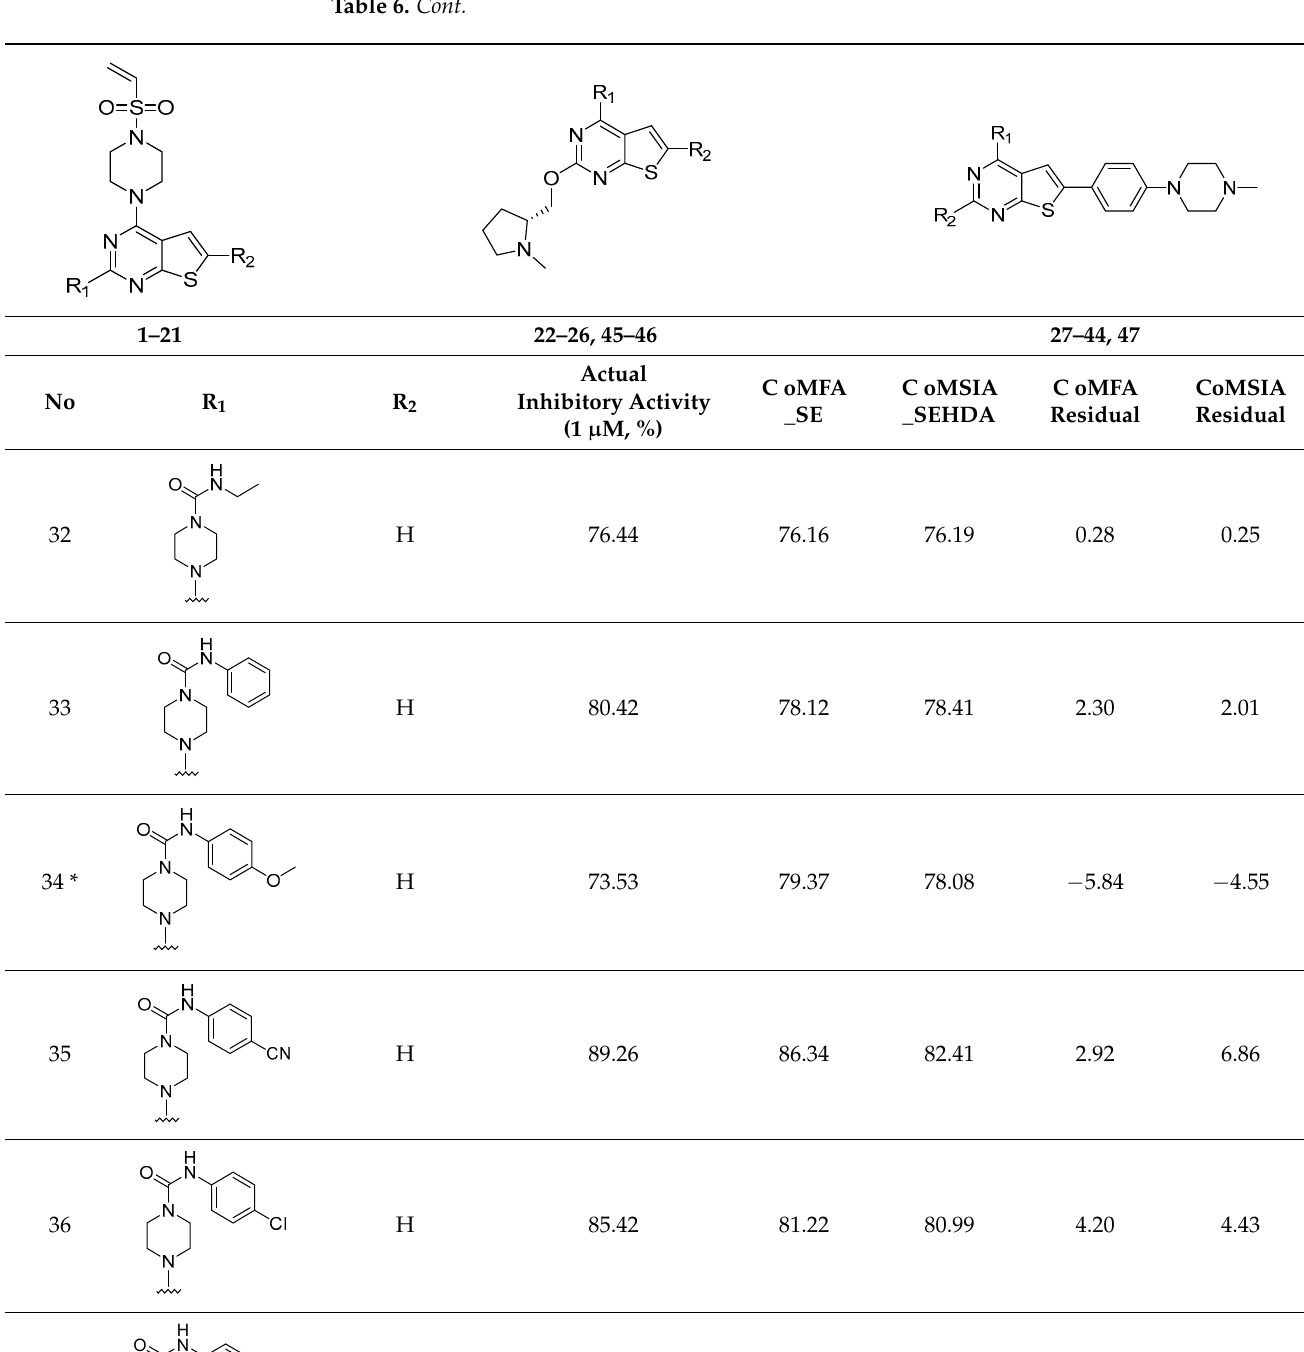
Table 6. Chemical structures and inhibitory activity values of thieno-pyrimidine derivatives. Table 6. Cont.